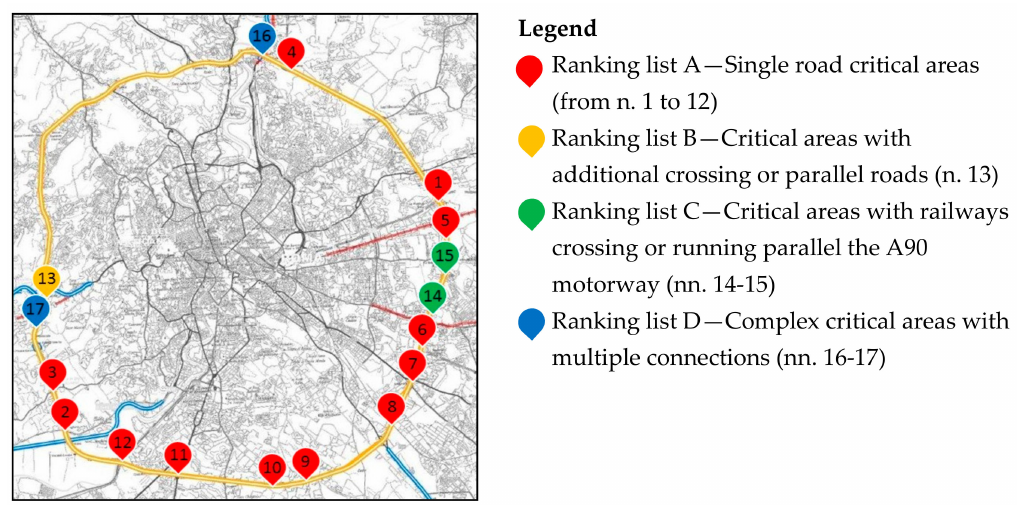
Figure 1. Rome pilot area. In red are reported the locations related to the ranking list A; in yellow the hot spots related to the ranking list B; in green the areas related to the ranking list C; and in blue those related to the ranking list D.